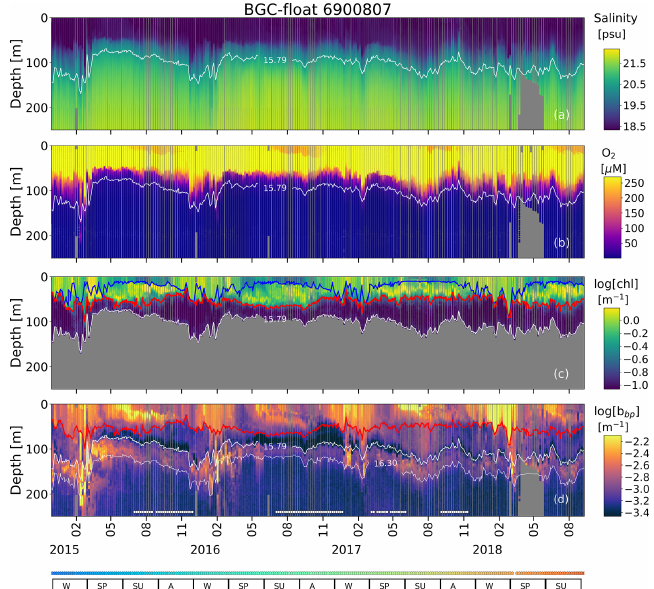
Figure A3. Same as Fig. A2 but for float